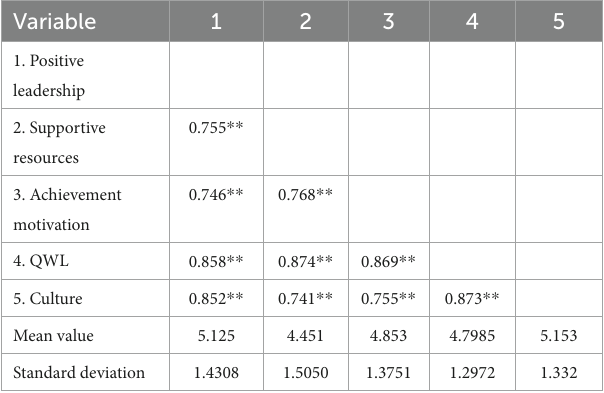
TABLE 4 Mean, standard deviation, and correlation coefficient of each variable ( N = 473).